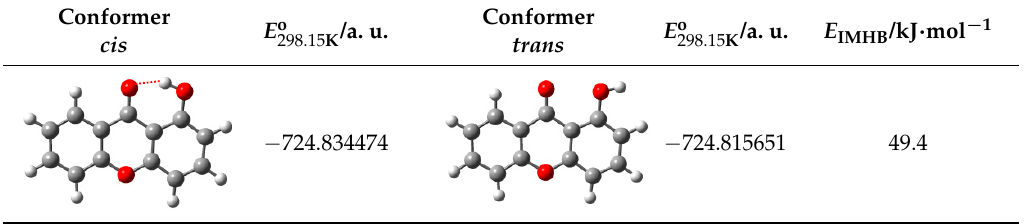
Table 3. Energies values for 1-hydroxyxanthone conformers cis and trans , at T = 298.15 K, E o obtained from G3(MP2)//B3LYP composite method for the calculation of the intramolecular hydrogen bond energy, E IMHB . 1 a. u. (Hartree) corresponds to 2625.50 kJ mol − 1 a . Conformer